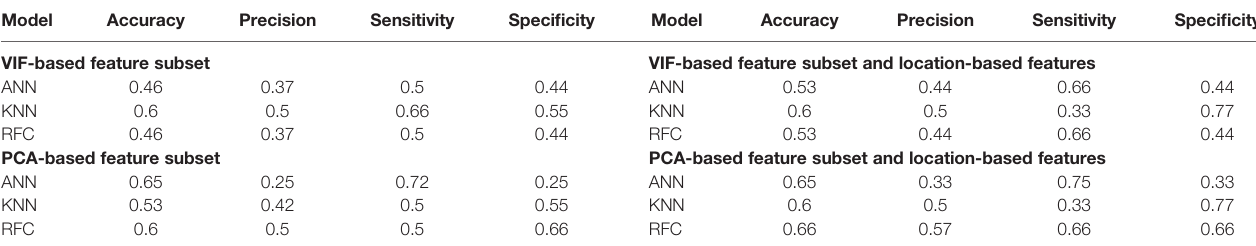
TABLE 3 | Performance comparison of classi fi cation models for patients ’ reported as NA.